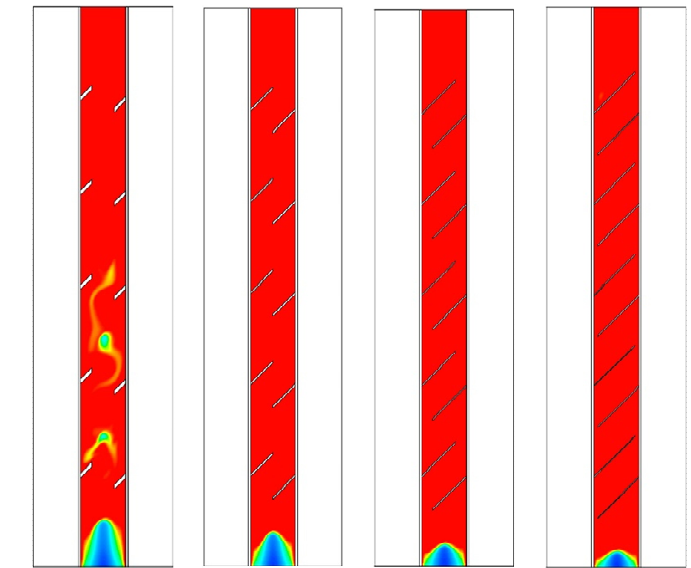
Figure 11. The liquid fraction development in 1800 s in three time steps for different dimensions including case 3 (2 × 7.071 mm 2 ), case 3a (1 × 14.14 mm 2 ), case 3b (0.666 × 21.21 mm 2 ), and case 3c (0.55 × 25.76 mm 2 ).